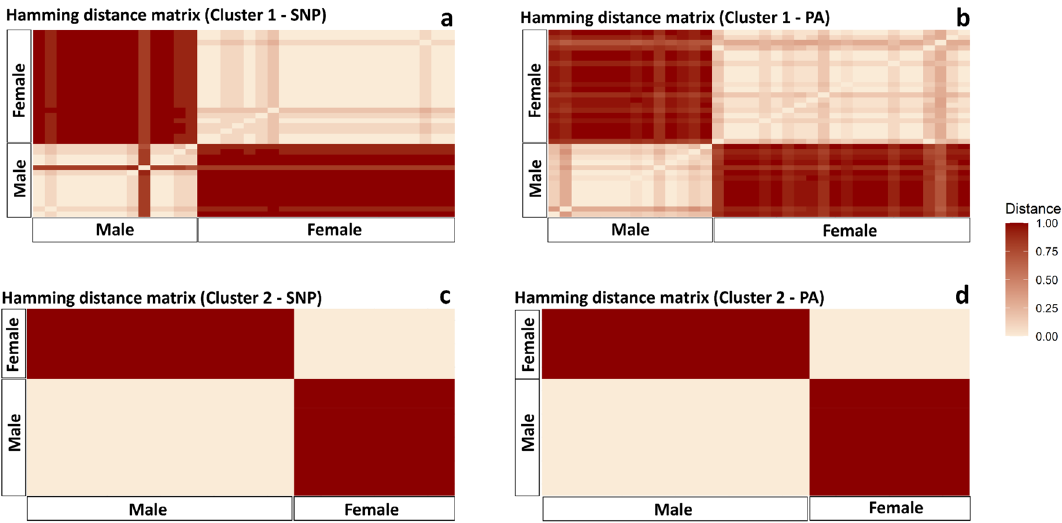
Figure 3. Hamming distance matrix using sex-linked SNP and PA loci in two clusters of Platyplectrum ornatum . ( a ) genetic distance using SNP loci among individuals of cluster 1. ( b ) genetic distance using PA loci among individuals of cluster 1. ( c ) genetic distance using SNP loci among individuals of cluster 2. ( d ) genetic distance using PA loci among individuals of cluster